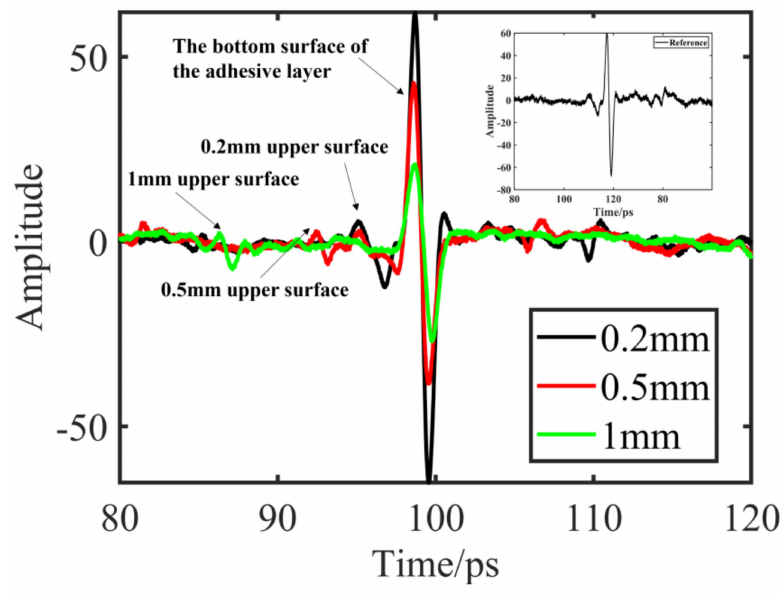
Figure 6. Terahertz time domain waveforms for three